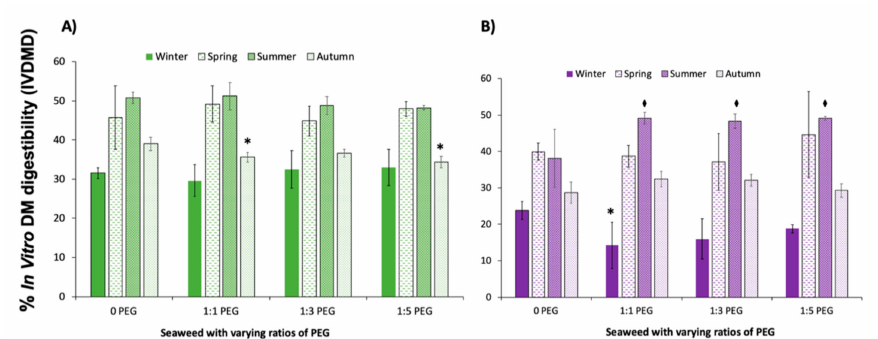
Figure 4. In vitro DM digestibility (IVDMD) profiles of ( A ) A. nodosum and ( B ) F. serratus with and without PEG. Three di ff erent ratios of PEG were used: 1:1, 1:3 and 1:5 phlorotannin:PEG ( p < 0.05, * = significant decrease; (cid:7) = significant increase).